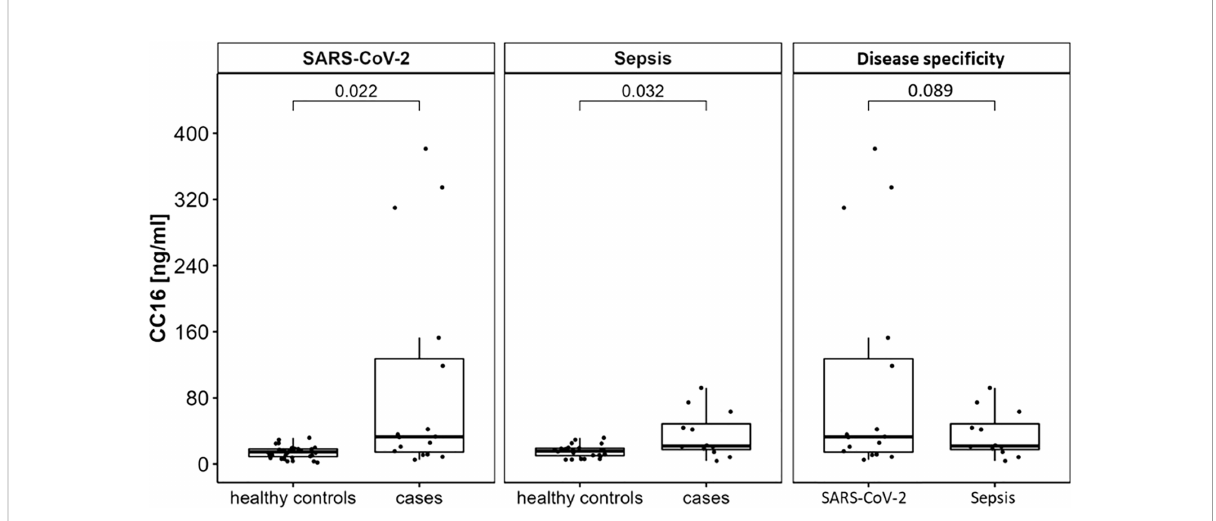
FIGURE 1 CC16 serum concentrations are signi fi cantly increased in patients experiencing either SARS-CoV-2 or non-pulmonary sepsis infection. Serum levels of n = 16 subjects hospitalized for severe SARS-CoV-2 infection and of n = 12 subjects hospitalized for severe sepsis infection were compared to age- and sex-matched healthy control subjects using Student ’ s t-tests. This displays signi fi cant higher serum concentrations in severe infection with and without pulmonary focus of infection. Data are presented as individual CC16 serum levels and as boxplots indicating the median, 25th, 75th percentile, minimum and maximum